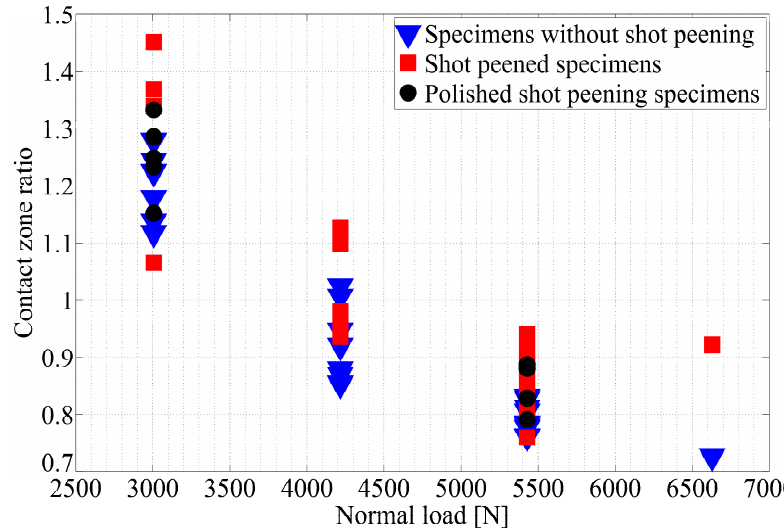
Figure 15. Ratio of experimental and theoretical contact size.